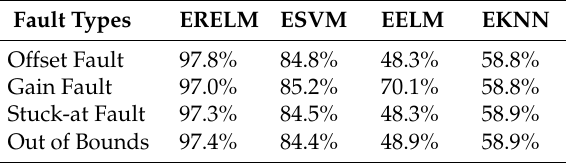
Table 7. DA with 50% induced